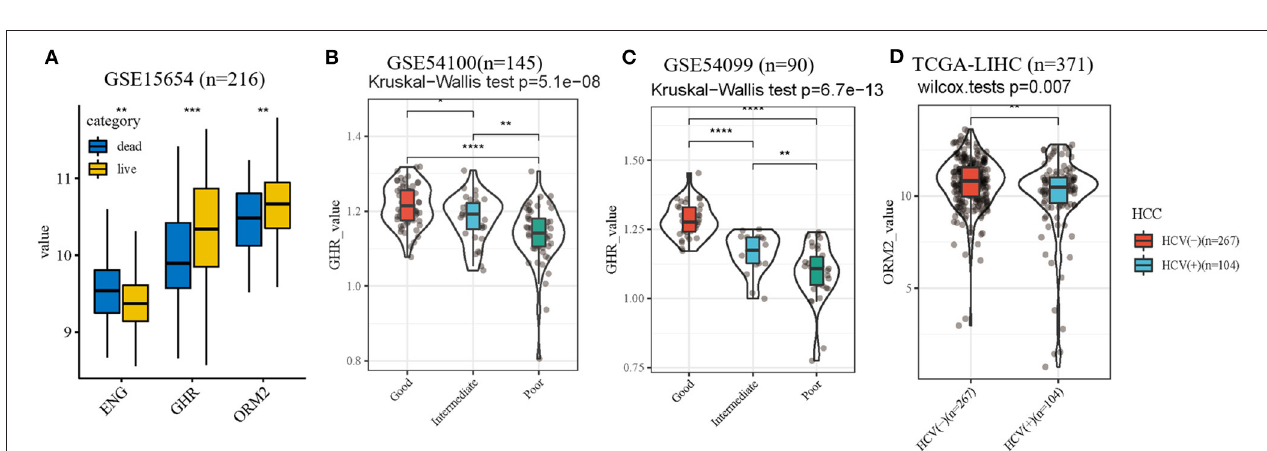
FIGURE 6 | Nomogram construction and validation. (A) the predictive nomogram. (B) the decision curve analysis and (C) ROC curve for the signature and clinical parameters. (D) 3-year, (E) 5-year and (F) 10-year calibration curves for OS.